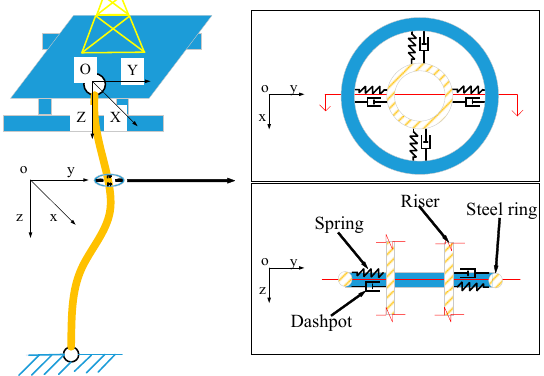
Figure 1. Schematic of the TMD and TTR model.